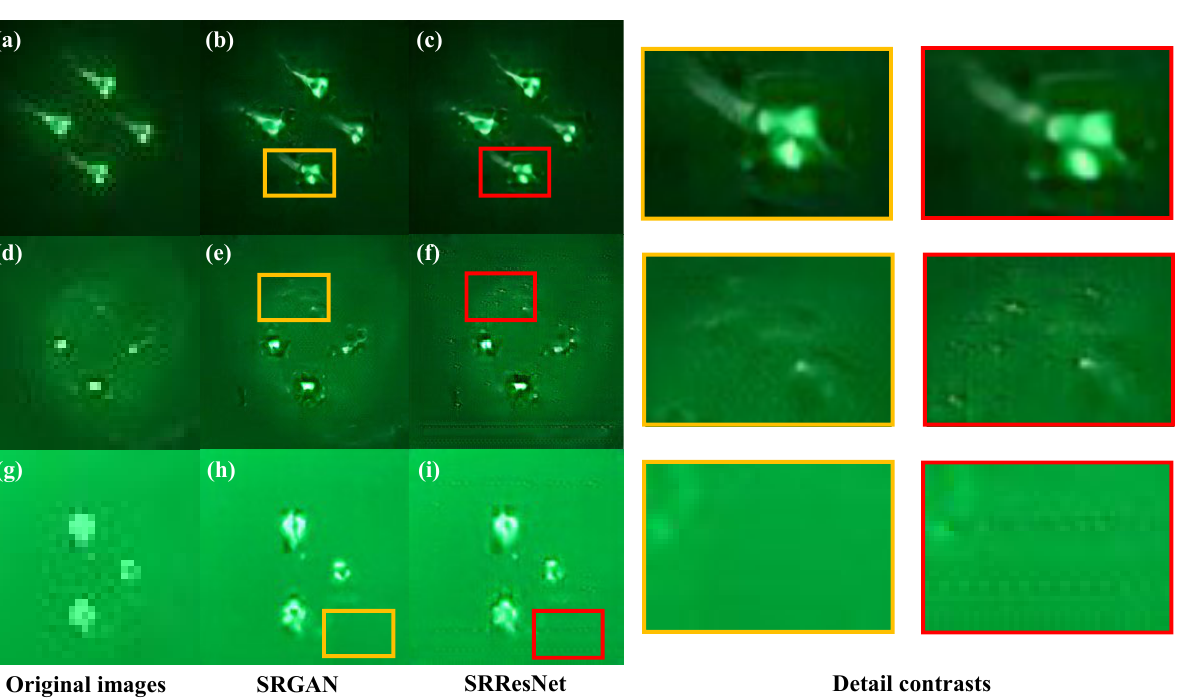
Figure 14. Comparison of the original images and the super-resolution reconstruction images: ( a , d , g ) are the original target images; ( b , e , h ) are super-resolution images of SRGAN; ( c , f , i ) are super- resolution images of SRResNet (the yellow box represents the SRGAN image detail, and the red box represents the SRResNet image detail).